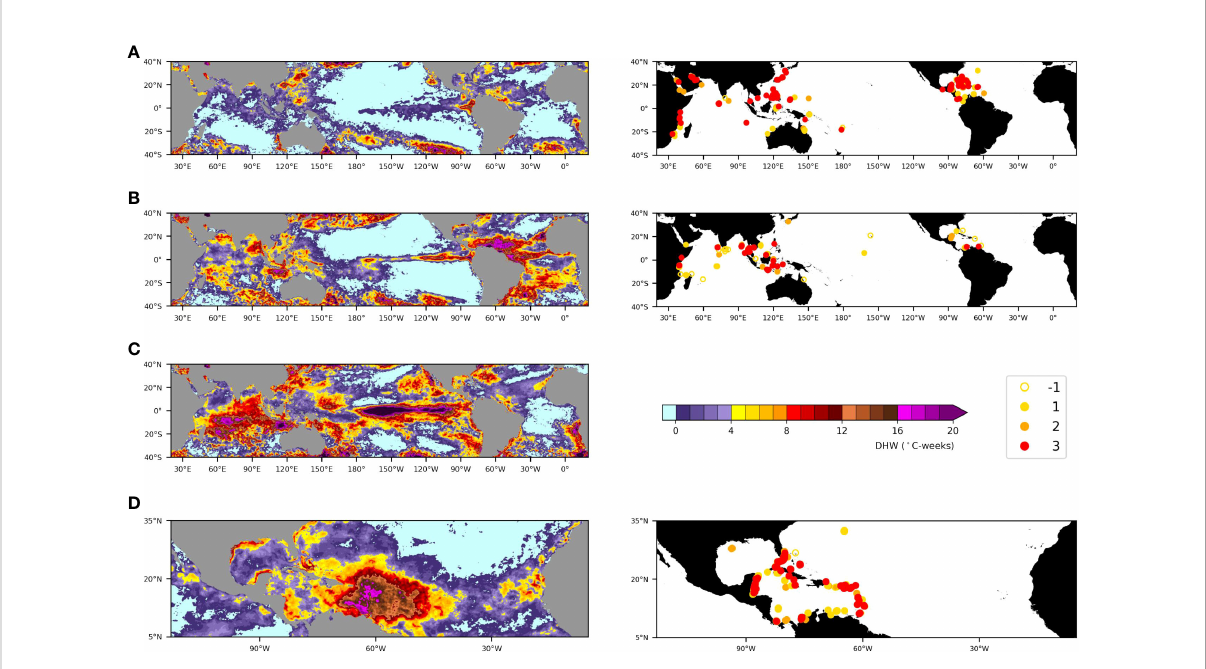
FIGURE 7 Charts of 5-km CoralTemp maximum DHW (left panels, colourbar in °C-weeks) and bleaching observations (right panels) around the globe (A) from the fi rst global coral bleaching event GCBE1 – August 1998 to April 1999, (B) during GCBE2 – April to December 2010, (C) during GCBE3 – January to September 2016 and (D) spanning the Caribbean regional bleaching event – June to October 2005. The legend indicates bleaching severity codes of Donner et al. (2017) – 3:severe (>50%); 2:moderate (11-50%); 1:mild (1-10%); -1:unknown